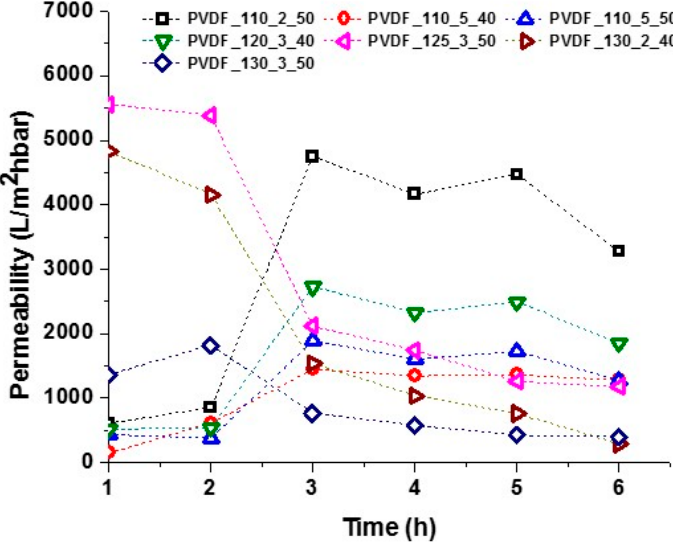
Figure 12. Separation of tap water using various laminated nanofibrous membranes.